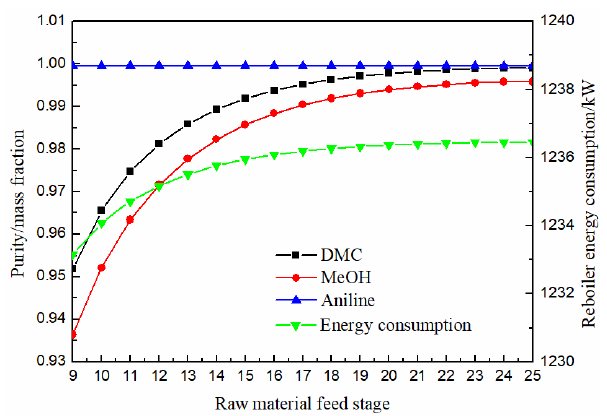
Figure 7. Effect of raw material feed stage on products purity and heat duty of reboiler.